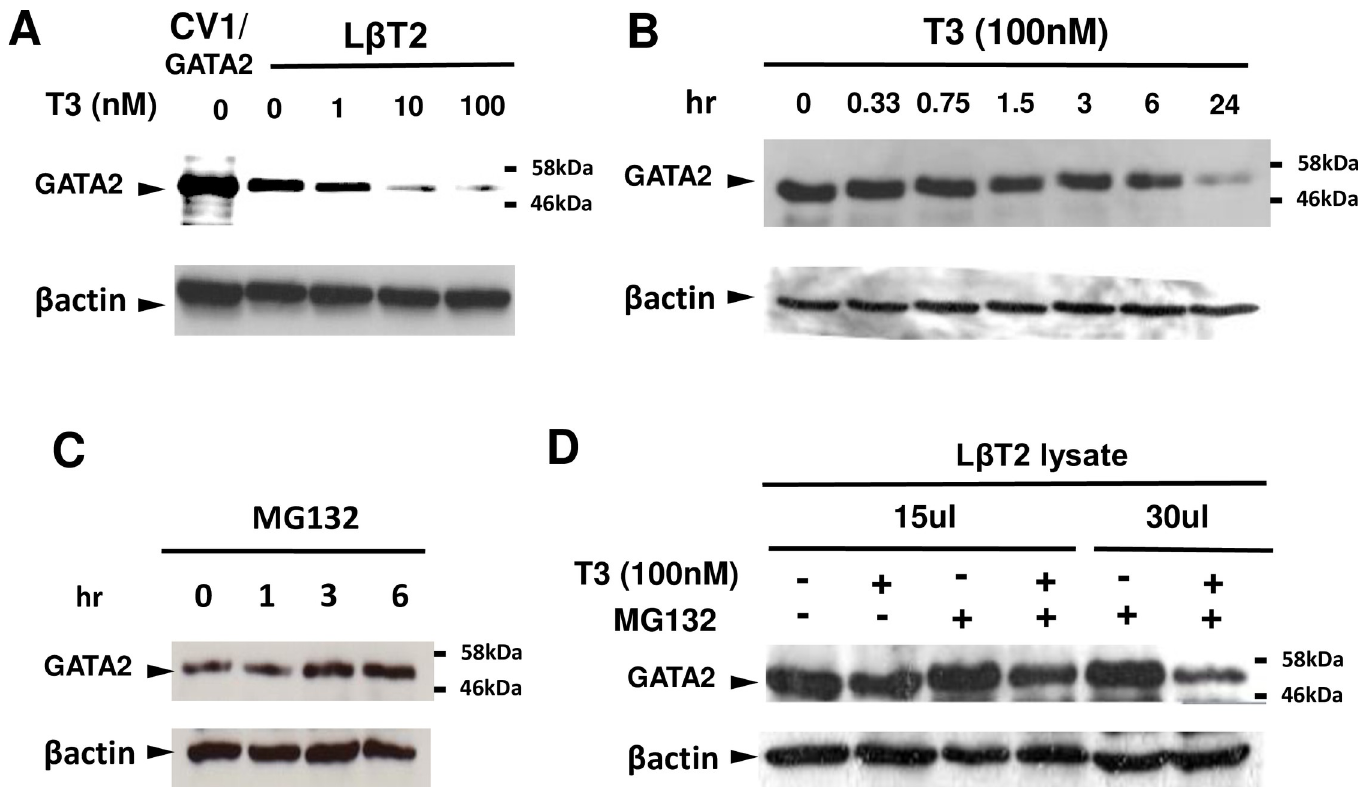
Fig 5. T3-dependent repression of GATA2 protein occurs independently of the ubiquitin-proteasome system. (A) Western blot with anti-GATA2 antibody for the whole cell extract of L β T2 cells plated in a 10-cm dish and treated with 0 to 100 nM T3 for 24 hr. CV1/GATA2: CV1 cells transfected with expression plasmid for mouse GATA2. (B) Western blot with anti-GATA2 antibody for the whole cell extract of L β T2 cells plated in a 10-cm dish treated with 0 to 100 nM T3 for 0 to 24 hr. (C) Western blot with anti-GATA2 antibody for the whole cell extract of L β T2 cells plated in a 10-cm dish and treated with 10 μ M MG132 for 0 to 6 hr before harvest. (D) Western blot with anti-GATA2 antibody for the whole cell extract (15 μ L/lane or 30 μ L/lane) of L β T2 cells plated in a 10-cm dish and treated for 24 hr with 10 μ M MG132 and 23.5 hr with 100 nM T3 before harvest.